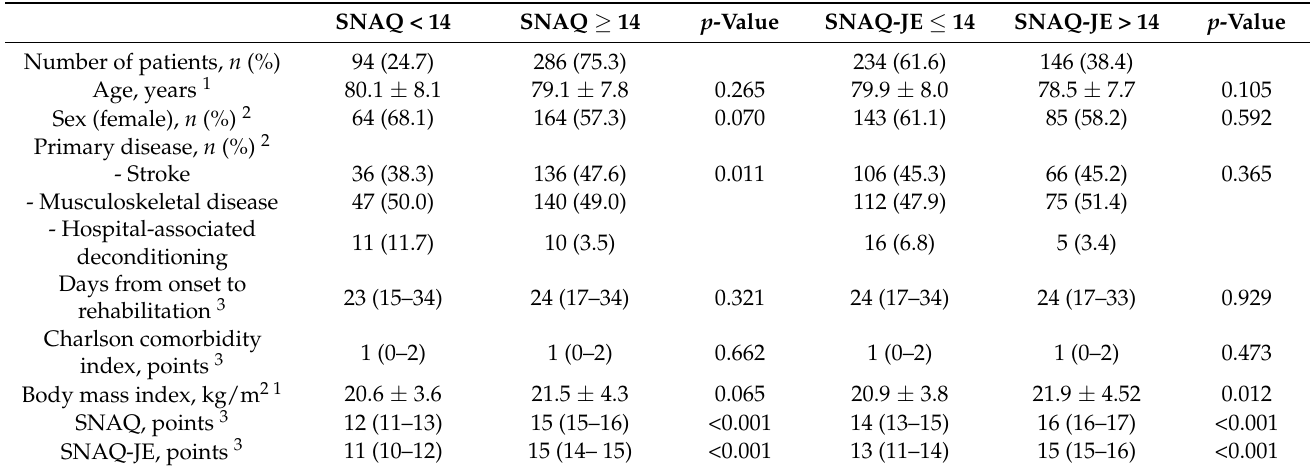
Table 1. Patients’ epidemiological characteristics according to appetite status.